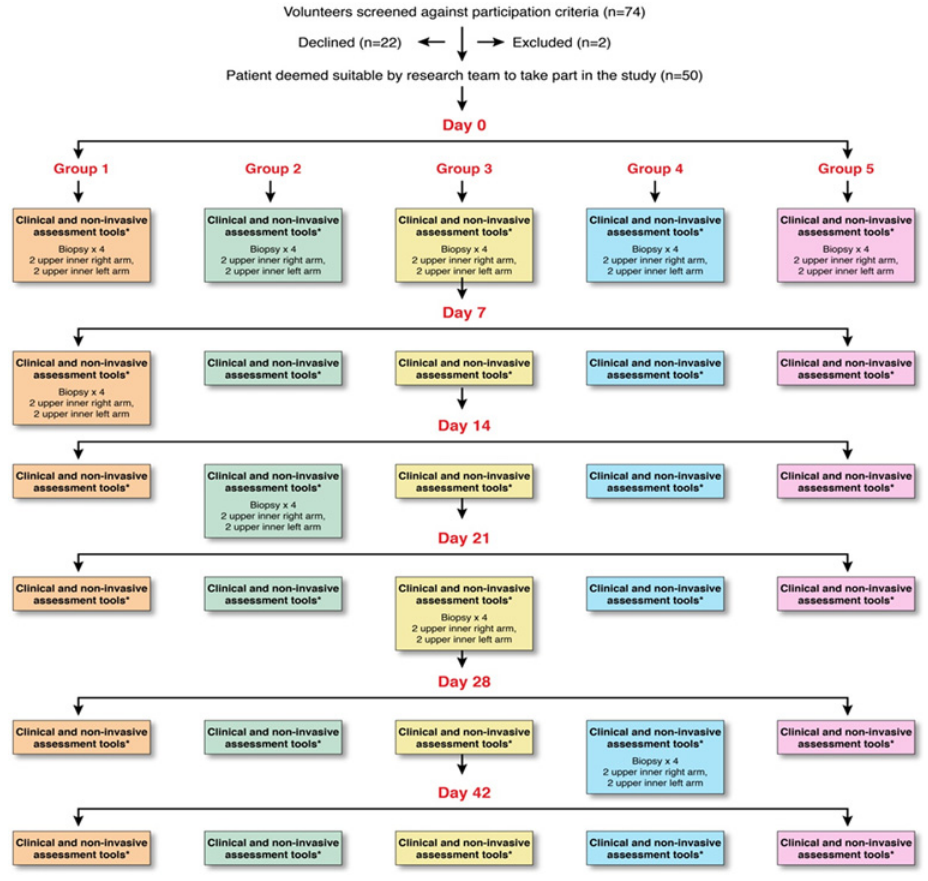
Figure 2. Cohort study flowchart. 74 volunteers were screened. 2 subjects did not fulfil recruitment criteria and were excluded. A further 22 declined to take part in the study. 50 participants were enrolled and